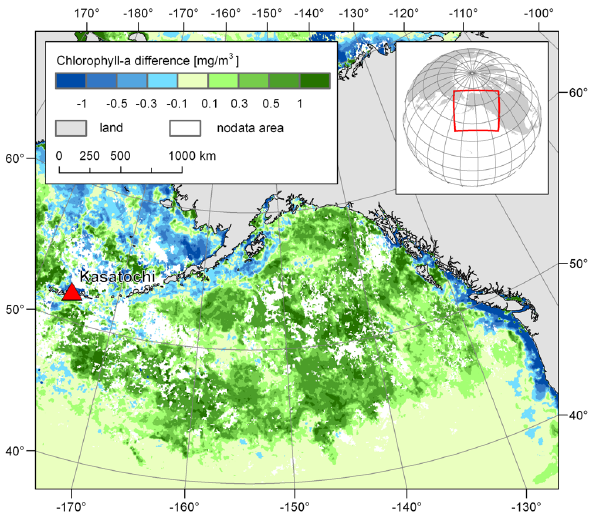
Fig. 1. MODIS Aqua chlorophyll a [mgm − 3 ] in the NE Pacific: August 2008 monthly mean minus average monthly mean 2002– 2007 (from Langmann et al., 2010a).